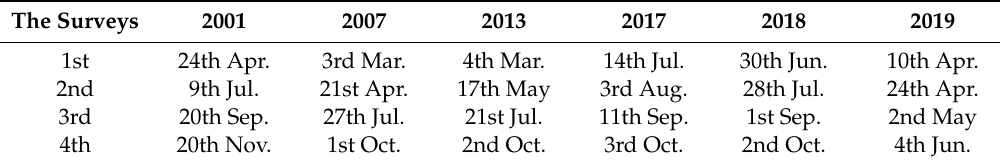
Figure 1. Sampling and measurement stations in Jakarta Bay (redrawn from Damar et al. [17]). Reproduced with permission from Elsevier and Damar, A.; Hesse, K.-J.; Colijn, F.; Yonvitner, Deep Sea Research Part II; published by Elsevier, 2019. Table 1. Dates of measurement